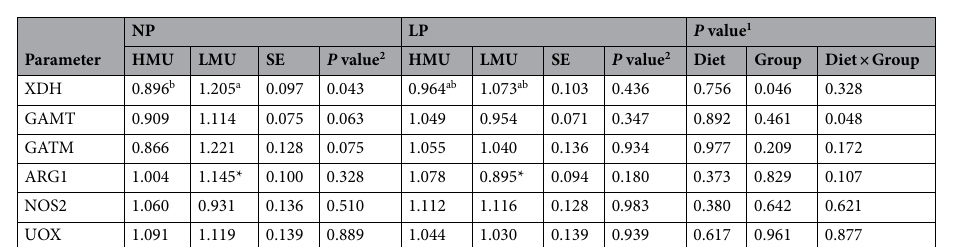
Table 5. Hepatic mRNA expressions of key enzymes involved in urea cycling, creatine and purine catabolism. Data are given as least square means and standard error (SE). a,b Different superscript letters within one row indicate P < 0.05 (Tukey-test). *Same symbol within one row indicate P < 0.1 (Tukey-test). XDH, xanthine dehydrogenase; GAMT, guanidinoacetate N-methyltransferase; GATM, glycine amidinotransferase; ARG1, arginase 1; NOS2, nitric oxide synthase; UOX, urate oxidase. 1 P value from ANOVA analysis. 2 P value from Tukey slice